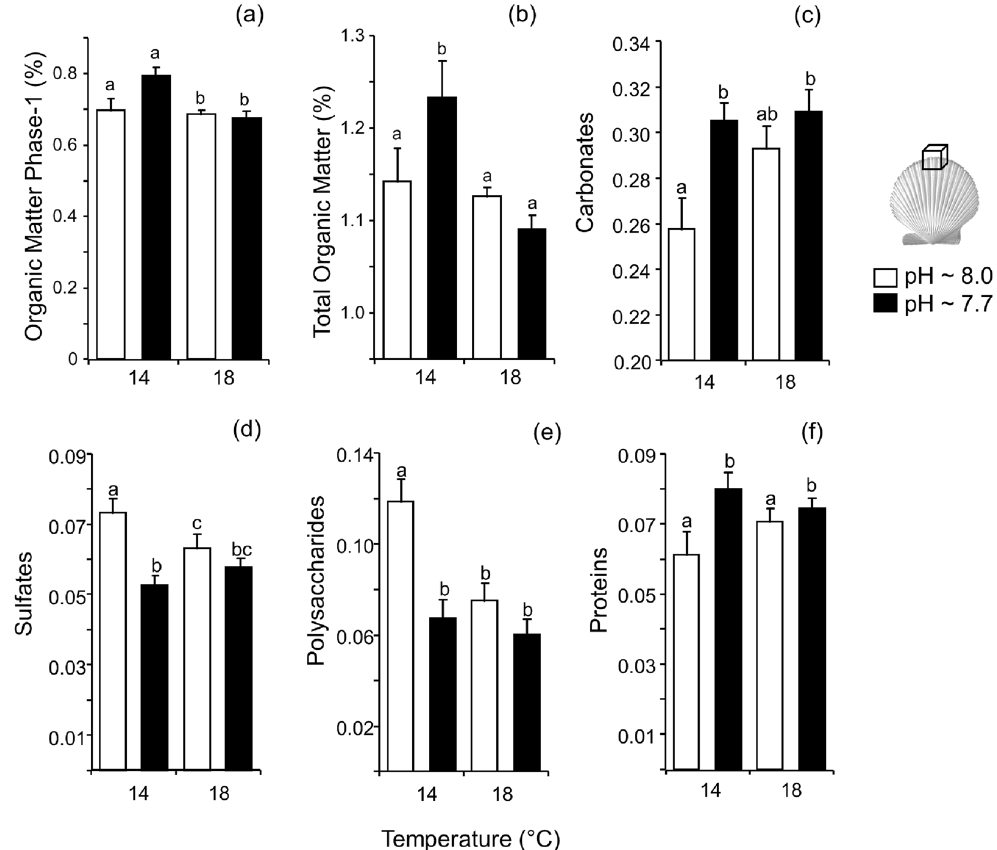
Figure 3. ( a , b ) Influence of temperature and pH on Argopecten purpuratus shell mineral composition (organic matter determined by TGA, % Mean ± SE); and ( c – f ) shell periostracum composition (determined by ATR-FTIR normalized signal, mean ± SE) Different letters represent significant differences among treatments using a post hoc Tukey HSD